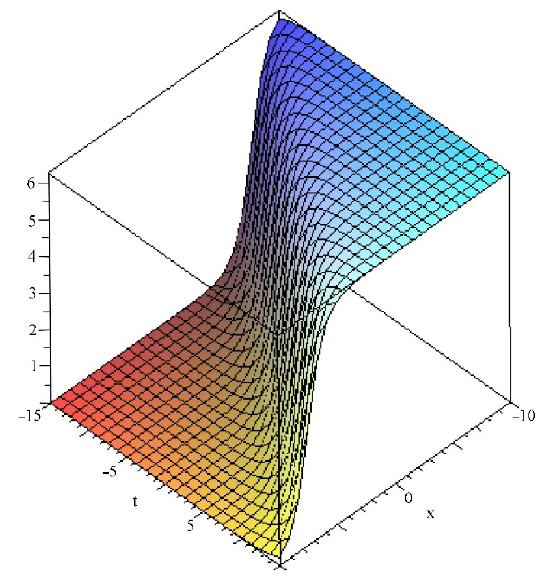
Figure 12. Geoblock displacement in the case of plastic deformation.